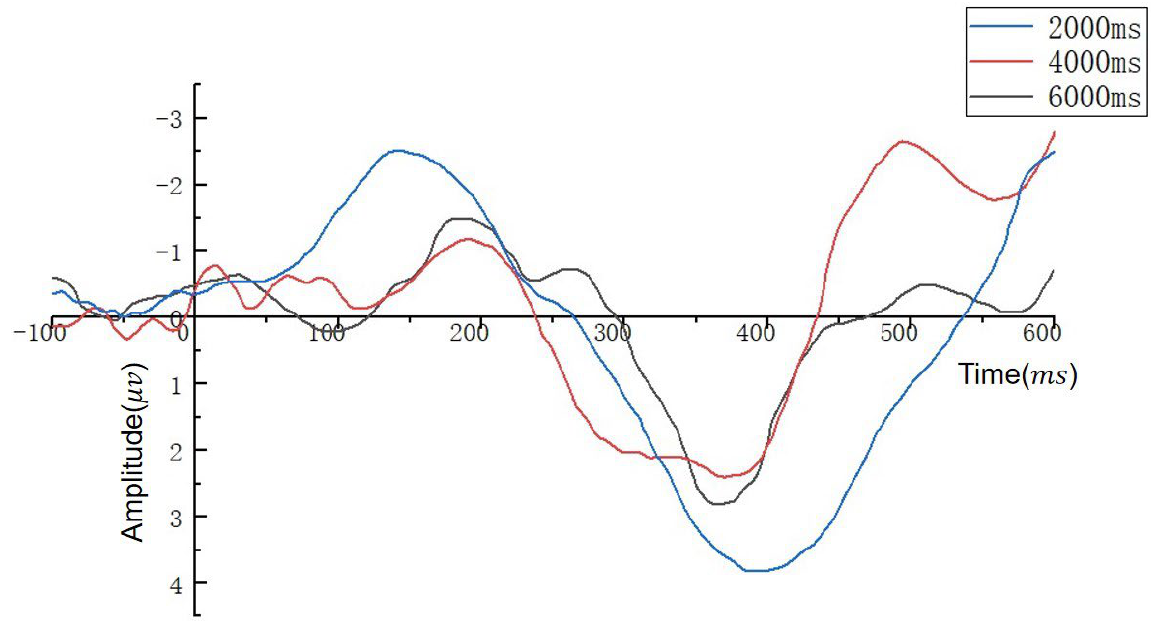
Figure 8. P300 time pressure waveform